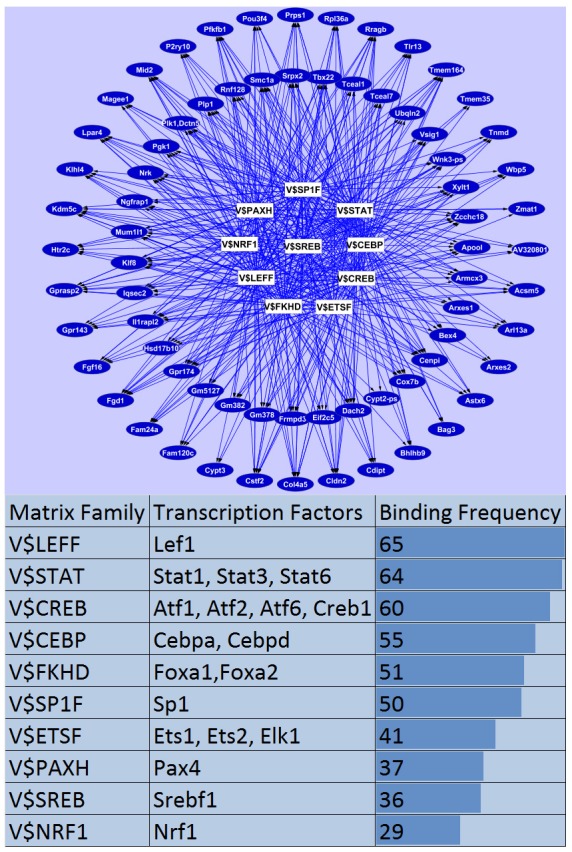
Putative SREBP co-factors mediating perinatal lung lipid homeostasis.A SREBP related transcriptional network was constructed based on the promoter analysis of genes within Clusters 5 and 7. Each connection between a matrix family (white rectangle) and a target gene (blue oval) represents at least one predicted binding site for a given transcription factor on the promoter region of that target gene.